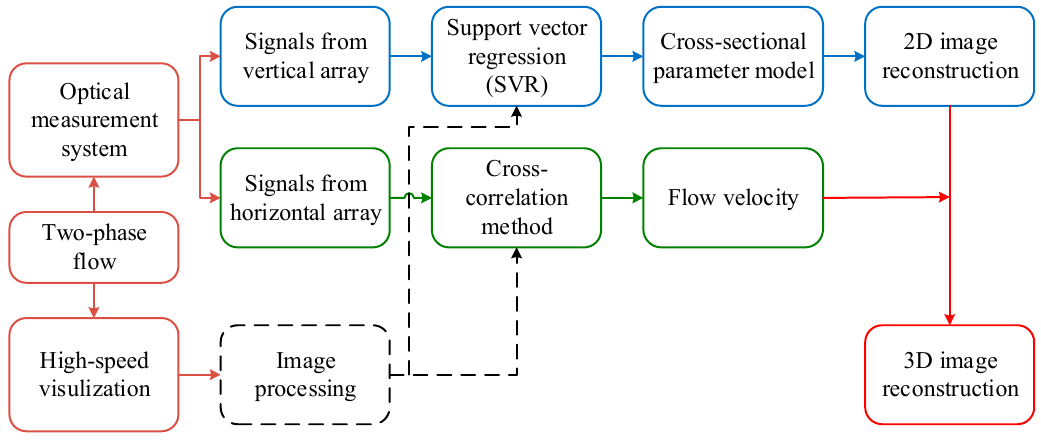
Figure 3. Flowchart of the 3D reconstruction procedure.